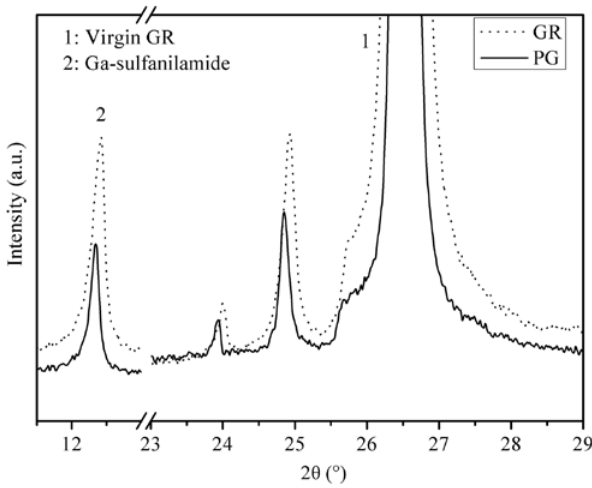
Figure 3: XRD patterns of the PG composite (line style: solid) and the as-received GR (line style: dot).